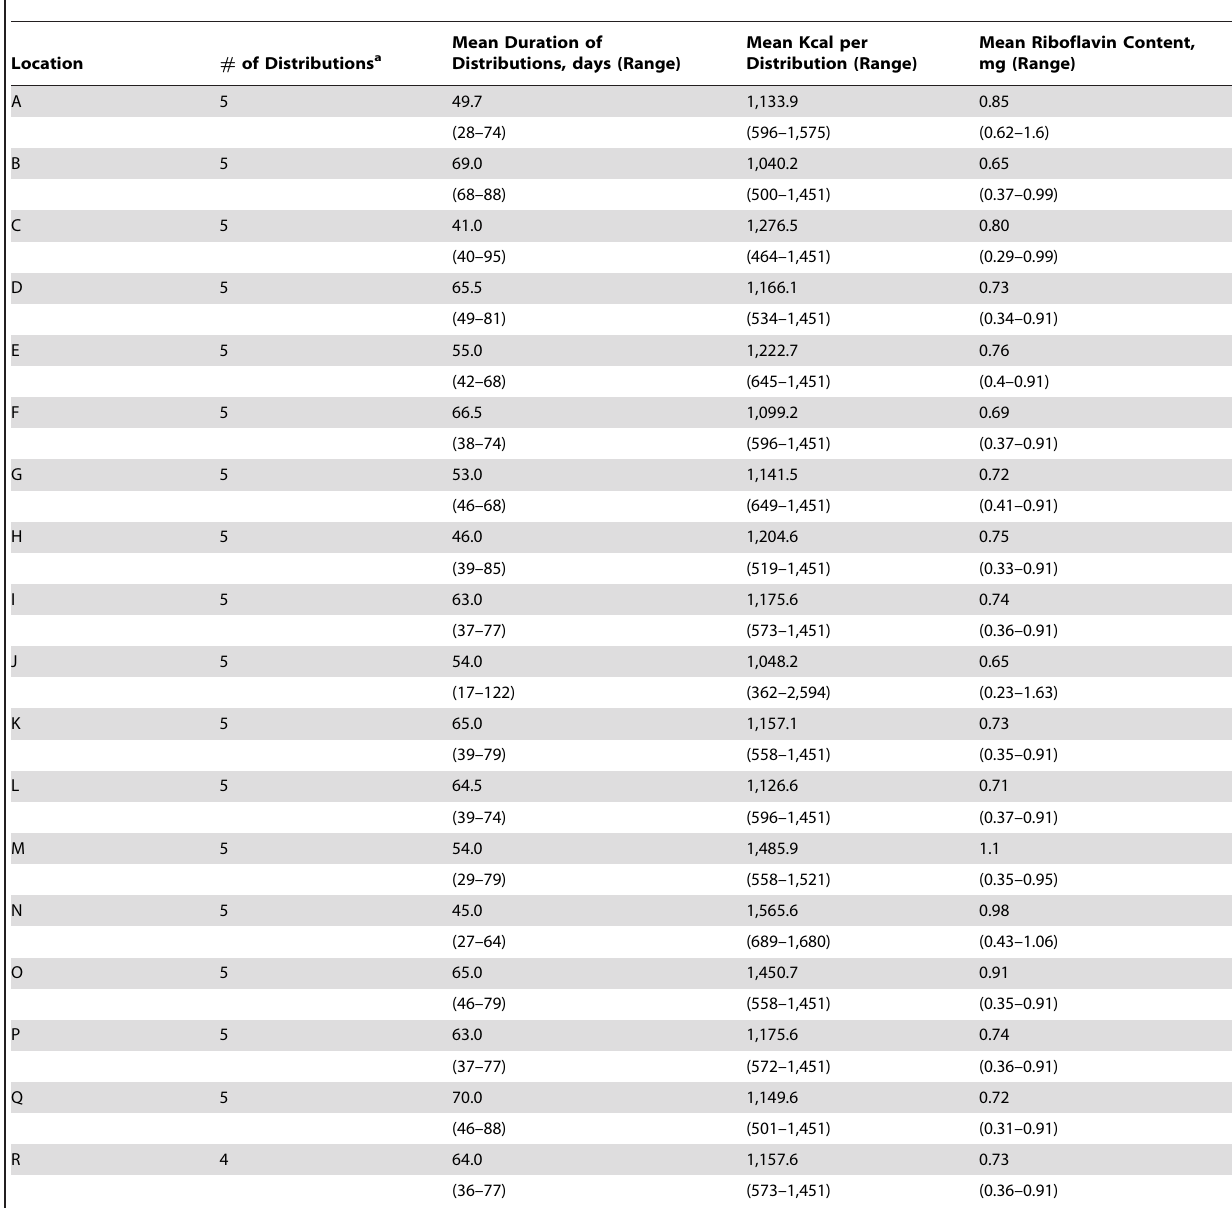
Table 3. Number and mean duration of distributions and mean energy (Kcal) and riboflavin content of actual ration distributed across 18 locations in Kotido District, Karamoja, Uganda – April-December